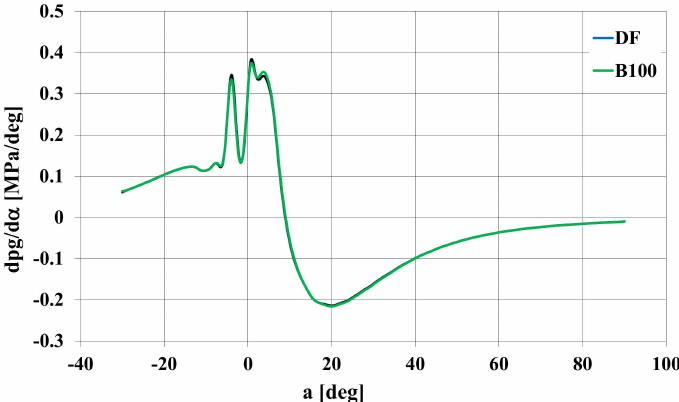
Figure 15. Process of the derivative of the pressure of the working factor in the cylinder-p g against the angle of rotation of the crankshaft-dp g /d α in the domain of the angle of rotation of the crankshaft-at the rotation speed of 1600 min − 1 for the engine powered with fuels DF diesel or